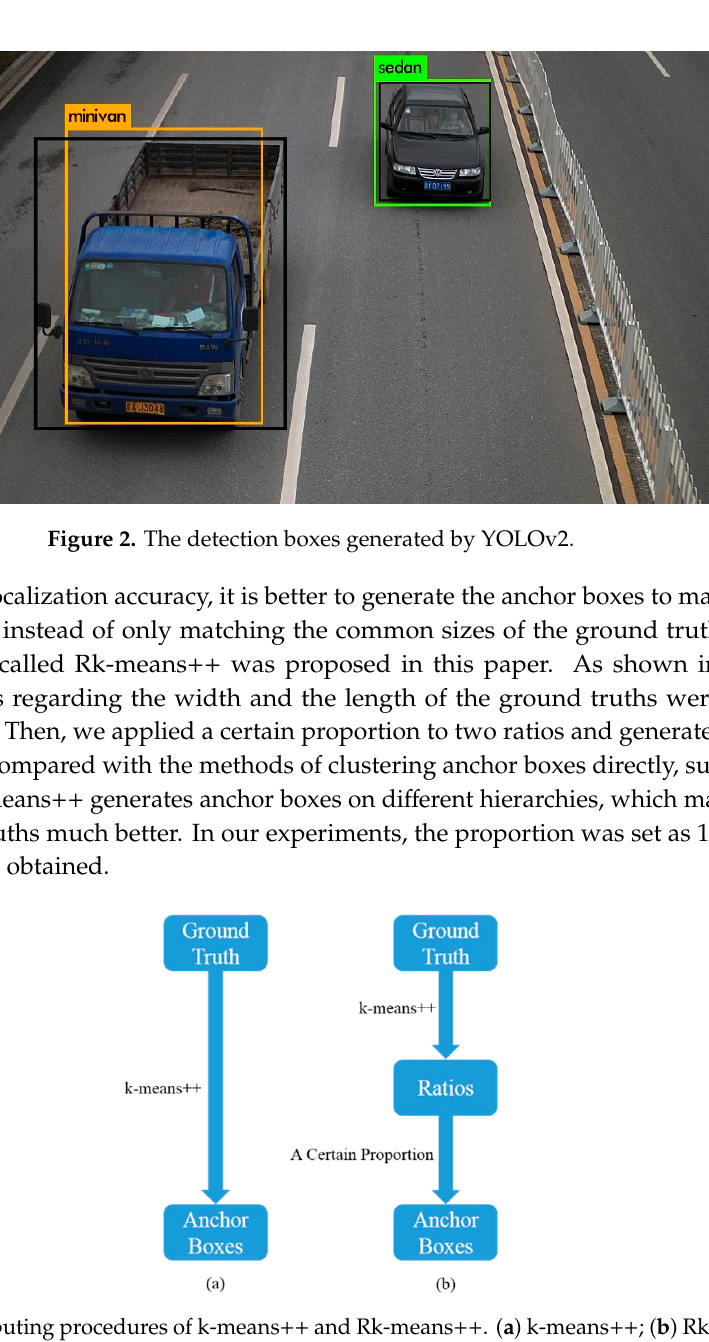
Figure 3. The computing procedures of k-means++ and Rk-means++. ( a ) k-means++; ( b ) Rk-means++. The anchor boxes obtained by Rk-means++ ensures that each size of the vehicle with different scale can be matched with one of the anchor boxes. In other words, the proposed anchor box generation method can enhance the robustness of YOLOv2 for different scales of vehicles and improve the localization accuracy.